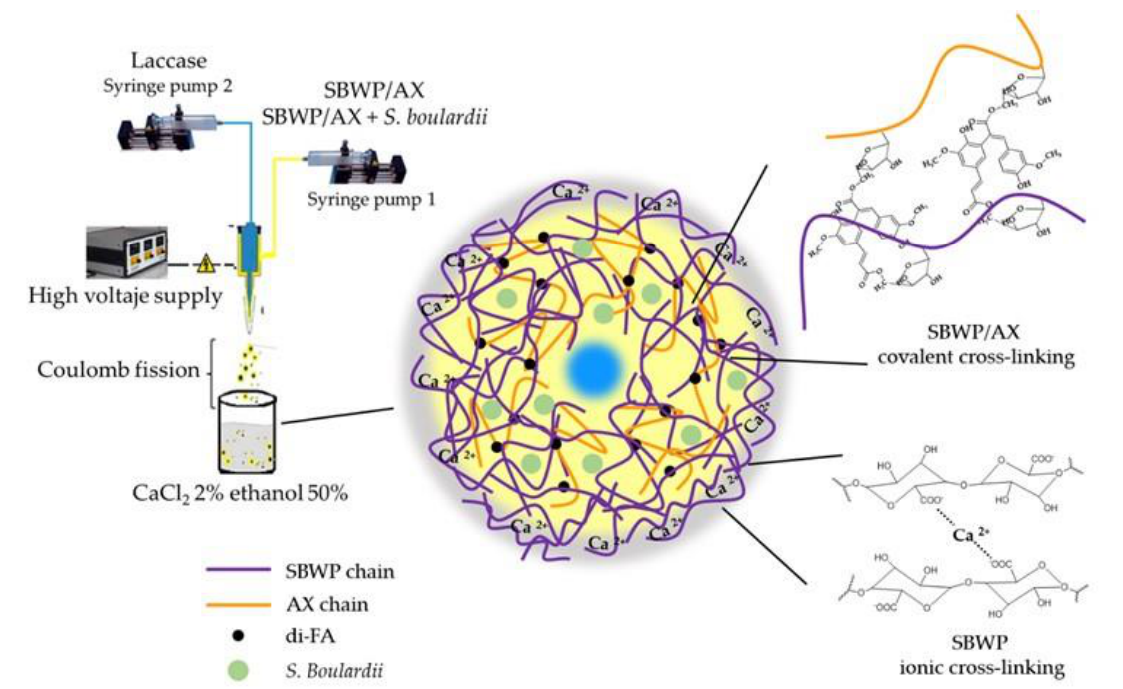
Figure 5. Scheme of coaxial electrospray process used to produce SBWP/AX and SBWP/AX+ S. boulardii microbeads.